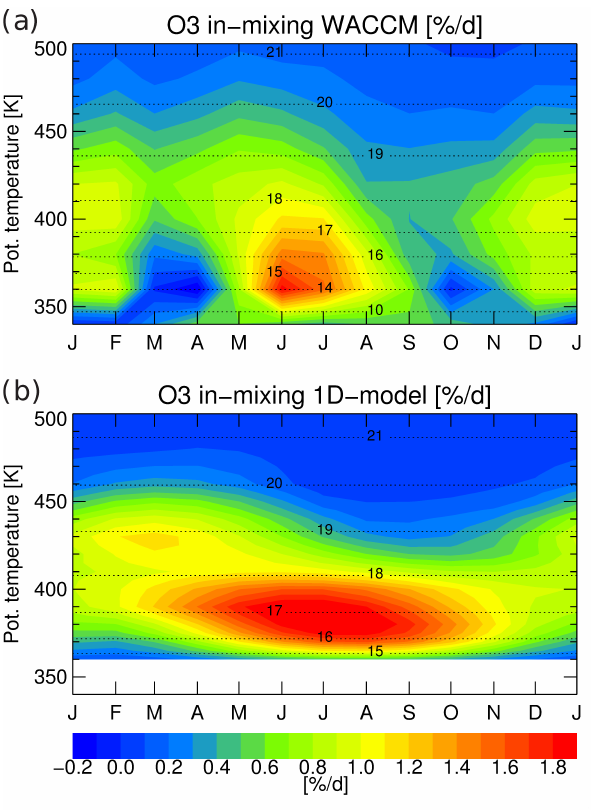
Fig. 3. Vertical structure of the seasonal cycle in in-mixing of ozone into the tropics (20 ◦ S–20 ◦ N). Shown is the in-mixing contribution to the ozone tendency relative to the annual mean ozone concentra- tion in [%day − 1 ], from WACCM (a) and from the 1-D model (b) . See text for details. Log-pressure annual mean altitudes for each model are indicated by the horizontal dotted lines and labeled in km. Color bar range is − 0.2 (blue) to 1.8 (red) [%day − 1 ].